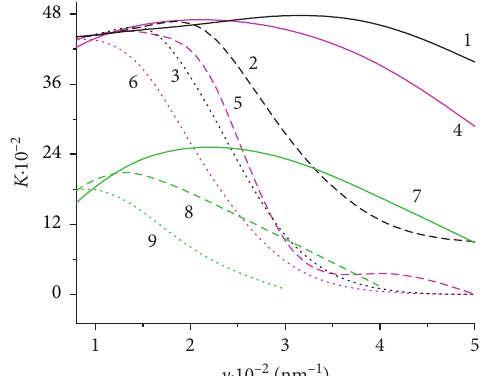
Figure 6: Contrast K of the evanescent field over irregularities of a random surface profile with a Gaussian correlation function, depending on the spatial frequency ] of this profile for cases when the profile correlation lengths correspond to σ � 14 . 2nm (curves 1, 4, and 7), σ � 23 . 7 nm (curves 2, 5, and 8), and σ � 33 . 1nm (curves 3, 6, and 9), and the standard deviation of the profile height corresponds to δ � 8nm (curves 1, 2, and 3), δ � 4nm (curves 4, 5, and 6), and δ � 1nm (curves 7, 8, and